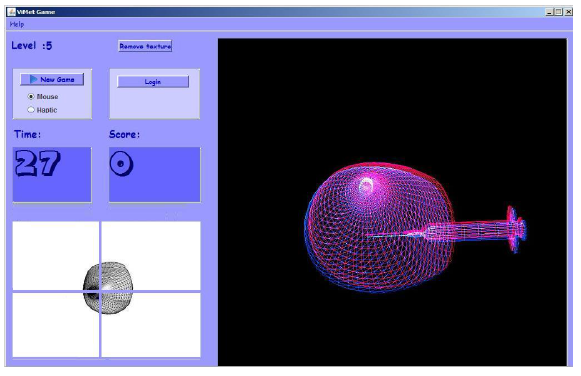
Figure 9. Level of the game with visualization using